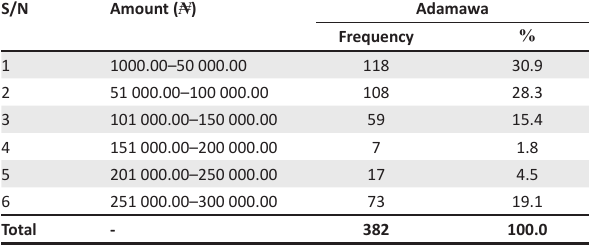
TABLE 4: Estimated losses in crop production.